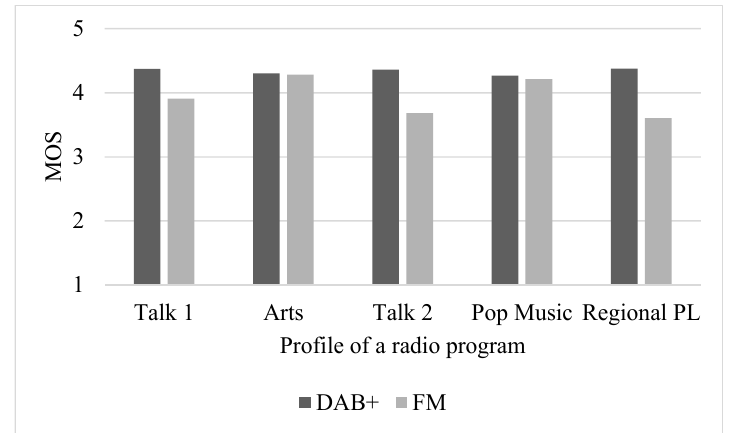
Figure 1. Subjective quality evaluation of simulcasted radio programs. According to obtained results, all scores favor the digital system. The observed difference ranges from 0.02 (Arts—broadcasted in DAB+ at 128 kbps) and 0.05 (Pop Music— broadcasted in DAB+ at 128 kbps) to 0.77 (Regional PL—broadcasted in DAB+ at 112 kbps). Moreover, a comparison has been performed by considering the results published in 2017 [25], including the same group of radio programs as well as the same number of individuals, namely 45, participating in the listening study. The results are shown in Fig- ure 2.